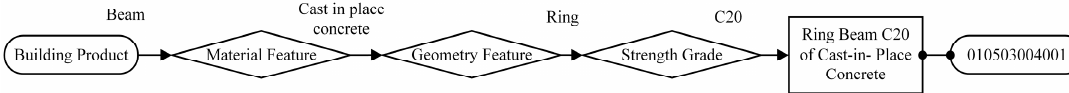
Figure 14. Reasoning result of the cost estimation ontology.